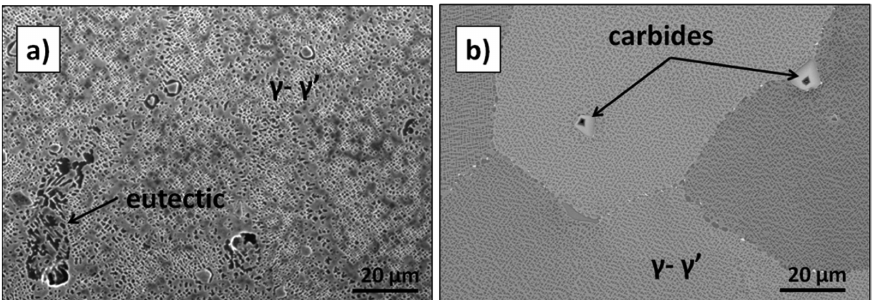
Figure 1: SEM images showing the microstructures of the cross-section of: (a) IN 792 and (b) Rene 80 in the as-received